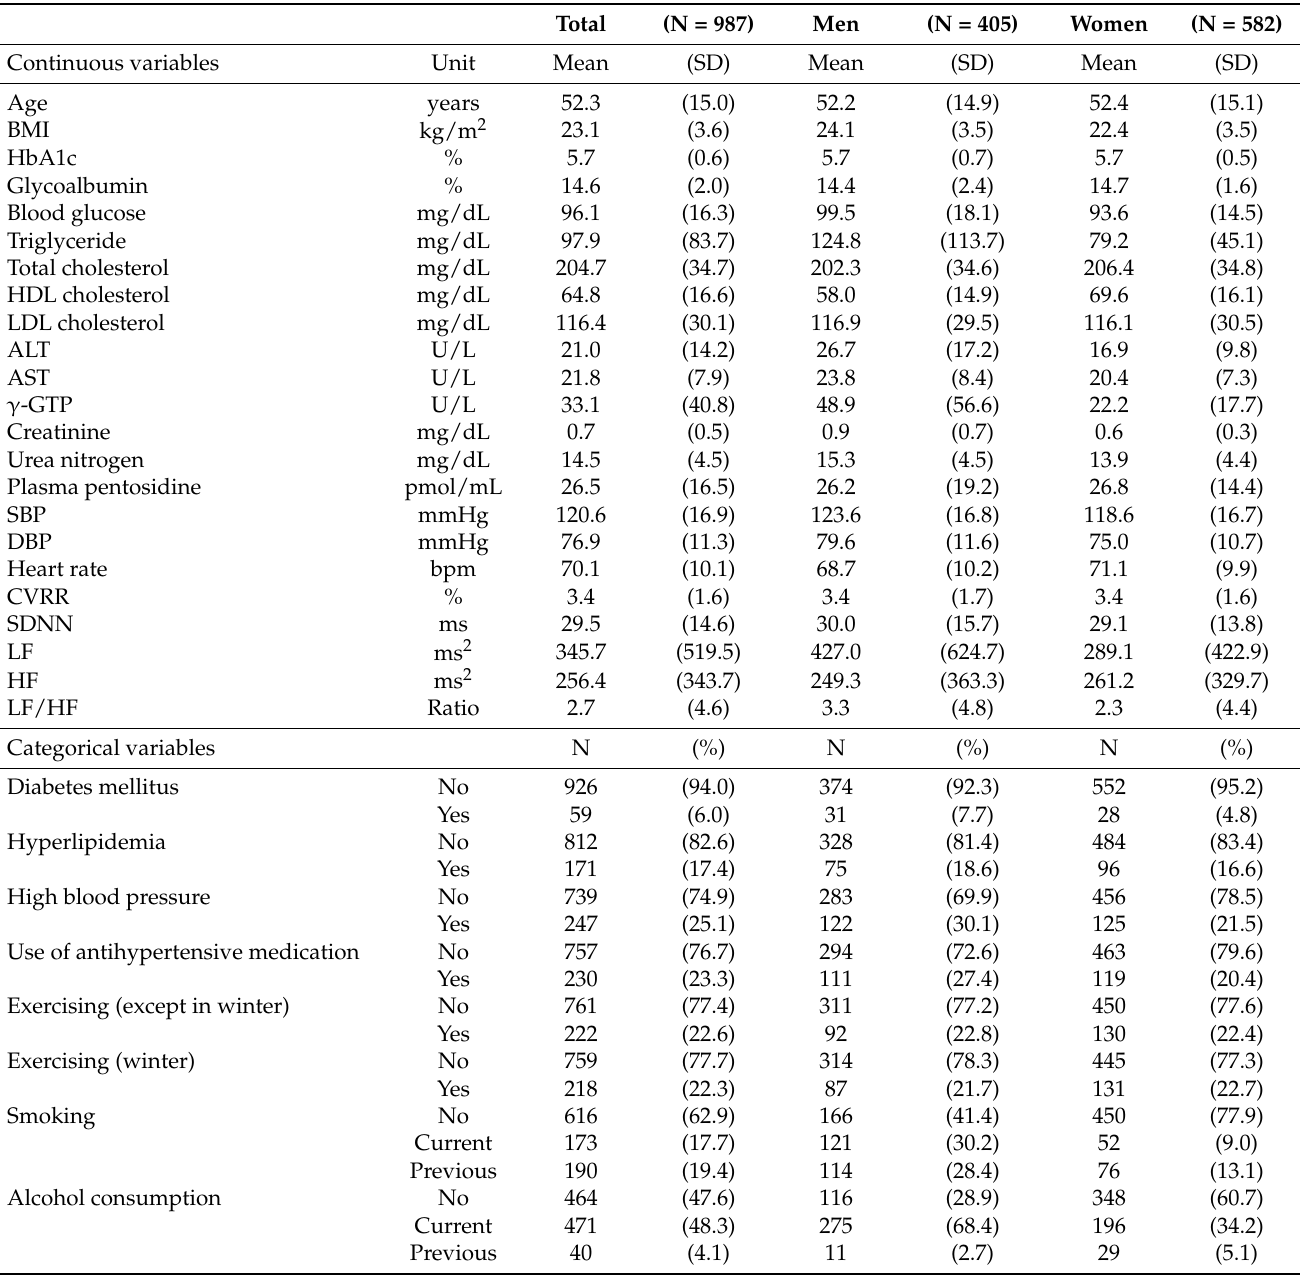
Table 1. Population